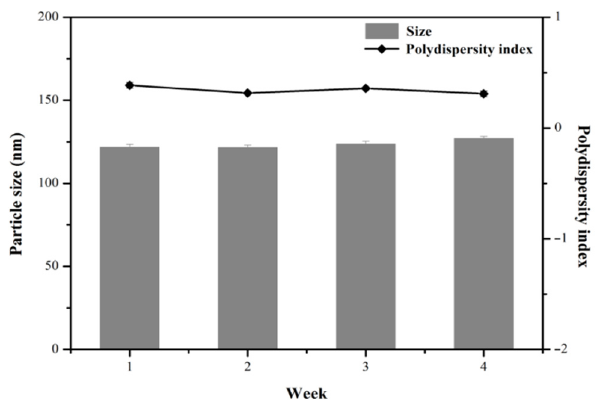
Figure 6. Particle size and size distribution of MPT0B291-human serum albumin (HSA) nanoparticles (NPs) stored at 4 °C for 4 weeks after reconstitution. Each point represents the mean ± SD. Error bars represent the standard deviation ( n = 3).